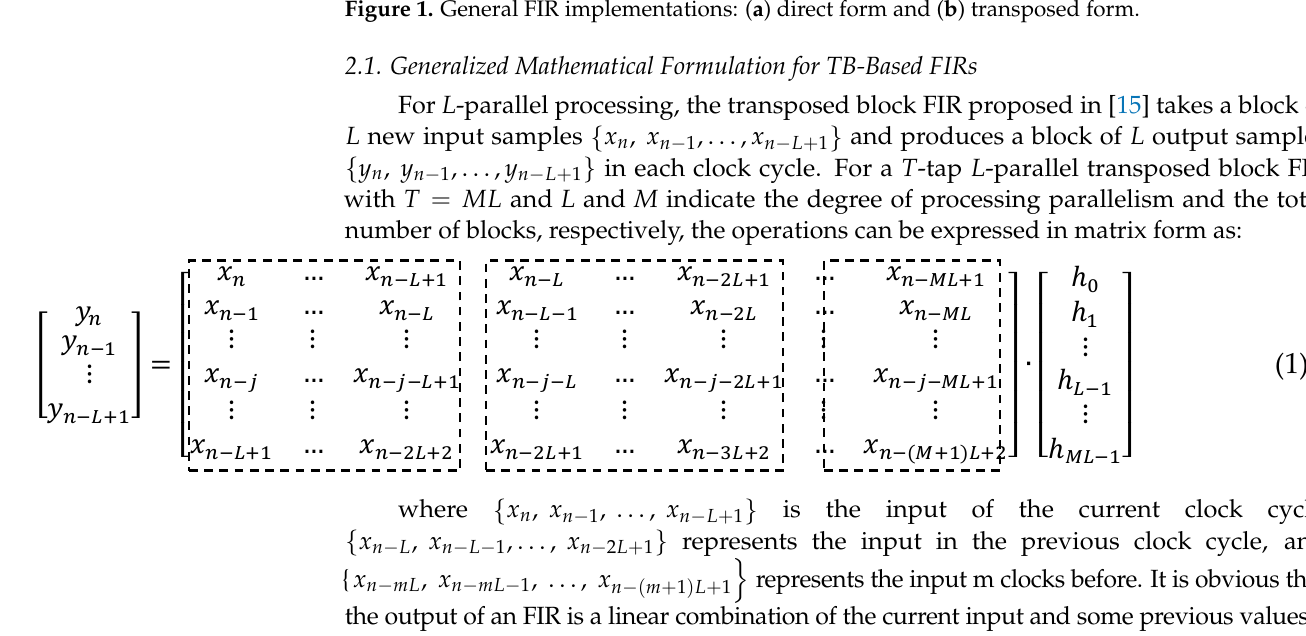
Figure 1. General FIR implementations: ( a ) direct form and ( b ) transposed form.